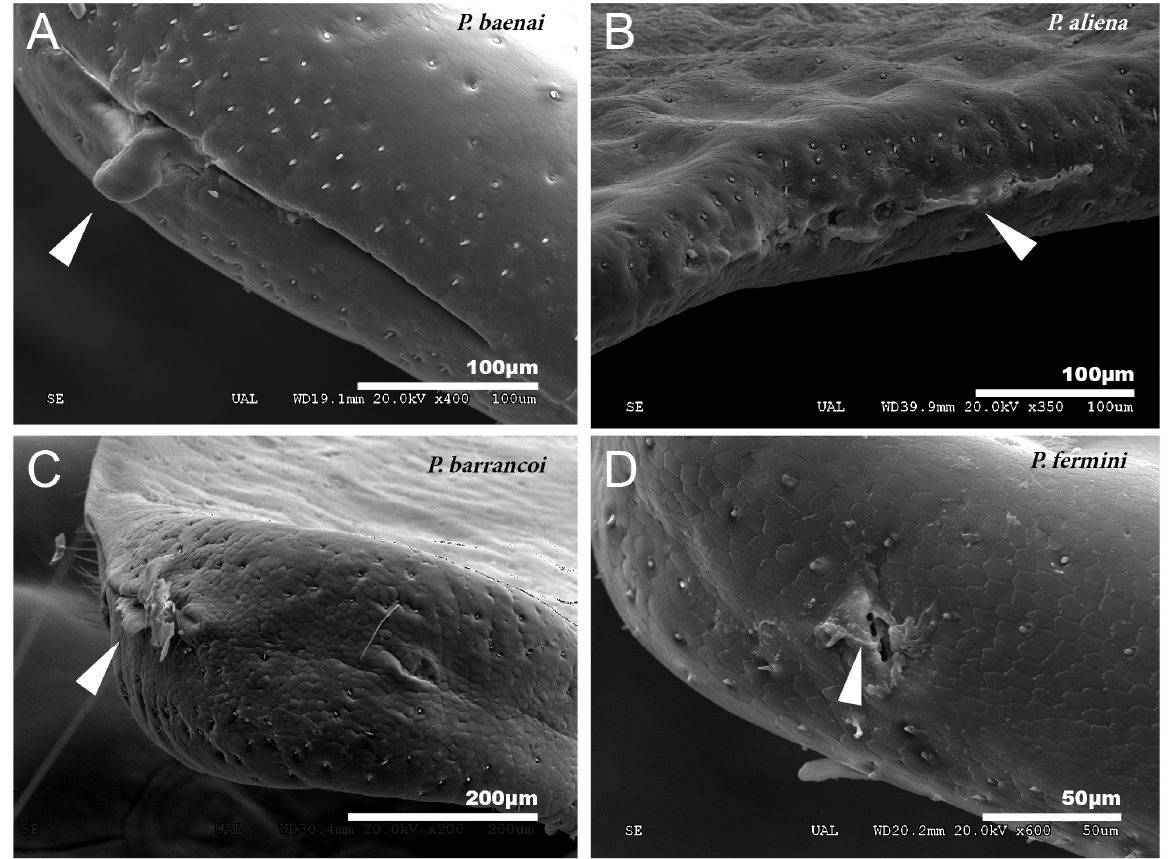
Figure 2. Gland openings. ( A ) Gland openings of P. baenai . This is characterized as in the rest of the species of the subgenus Zapetaloptila by presenting larger gland openings than in the subgenus Petaloptila , P. aliena ( B ). The apical gland openings are smaller in P. barrancoi ( C ) and P. fermini ( D ). The presence of secretion remains is indicated by arrowheads.